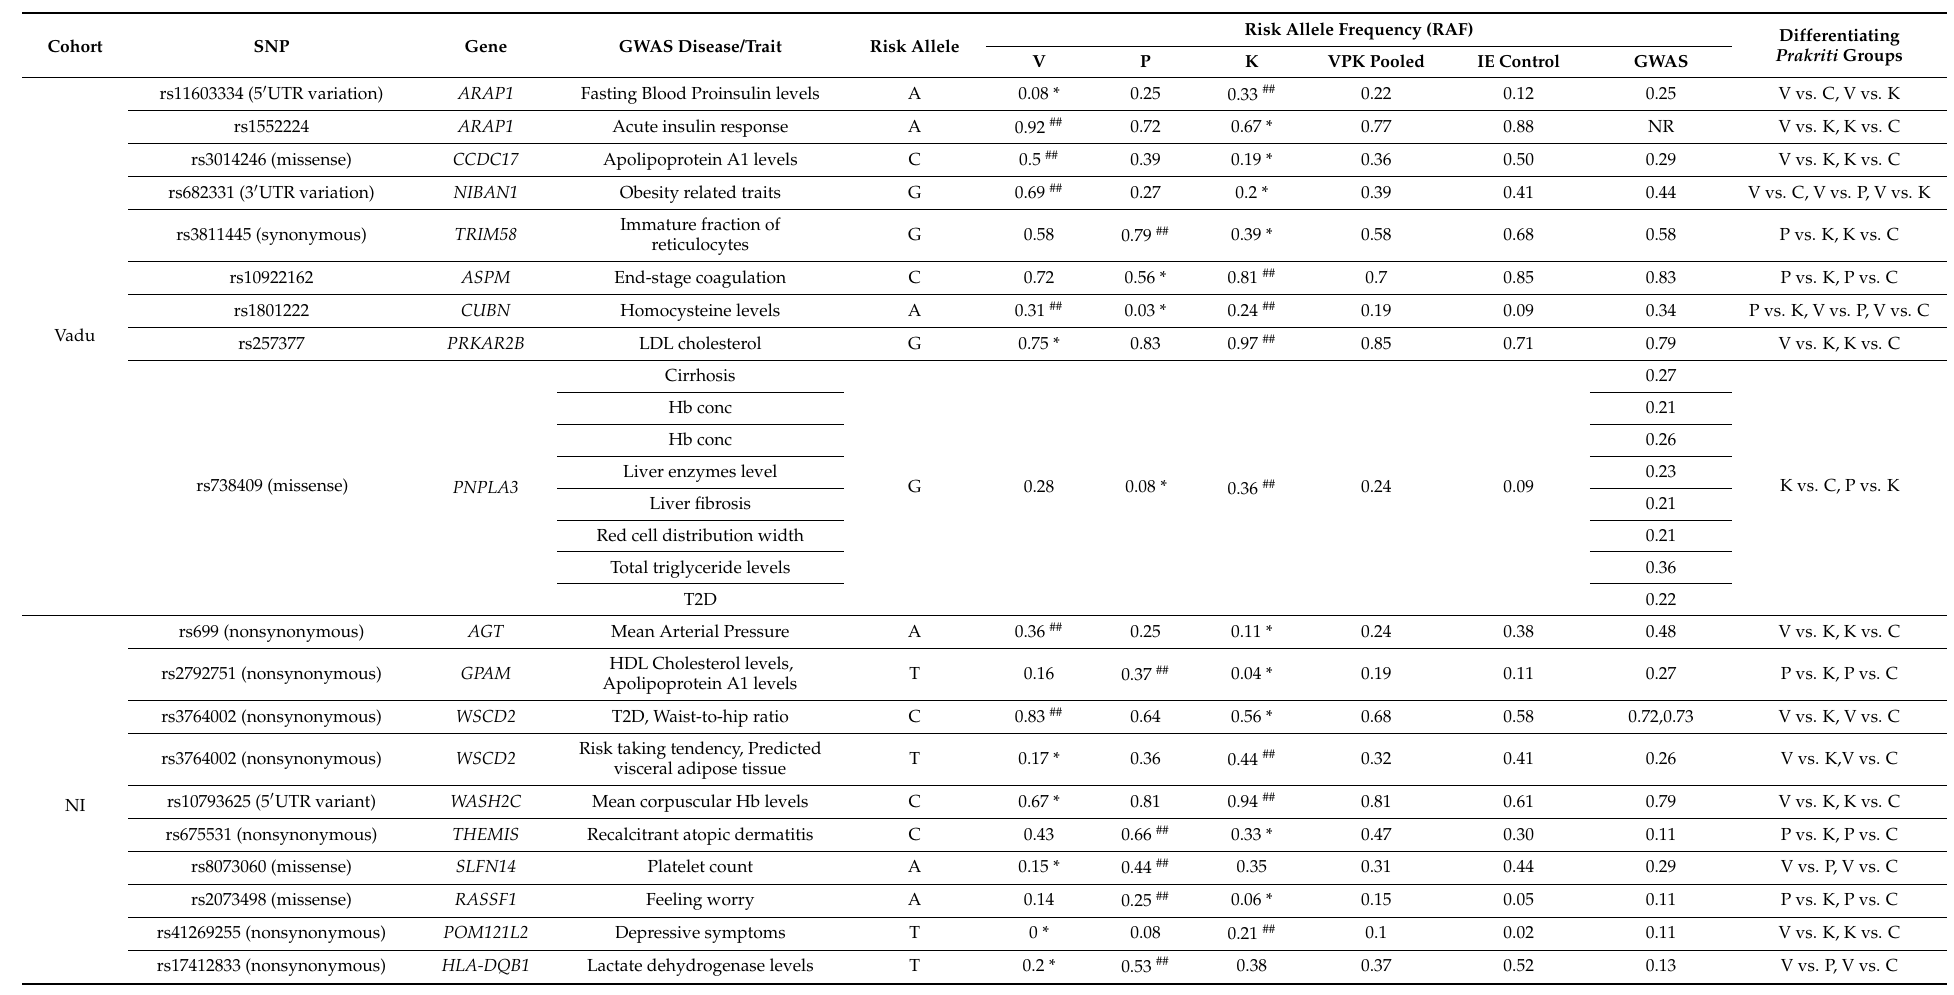
Table 1. List of disease/trait associated SNPs significantly differentiating between Prakriti groups as well as IE background control in NI and Vadu cohort. The risk allele frequency (RAF) of these SNPs in either of the Prakriti type is higher than the GWAS risk allele frequency, as shown in Figure S5A,B. Between the differentiating Prakriti groups, higher RAF is marked with ## , lower with